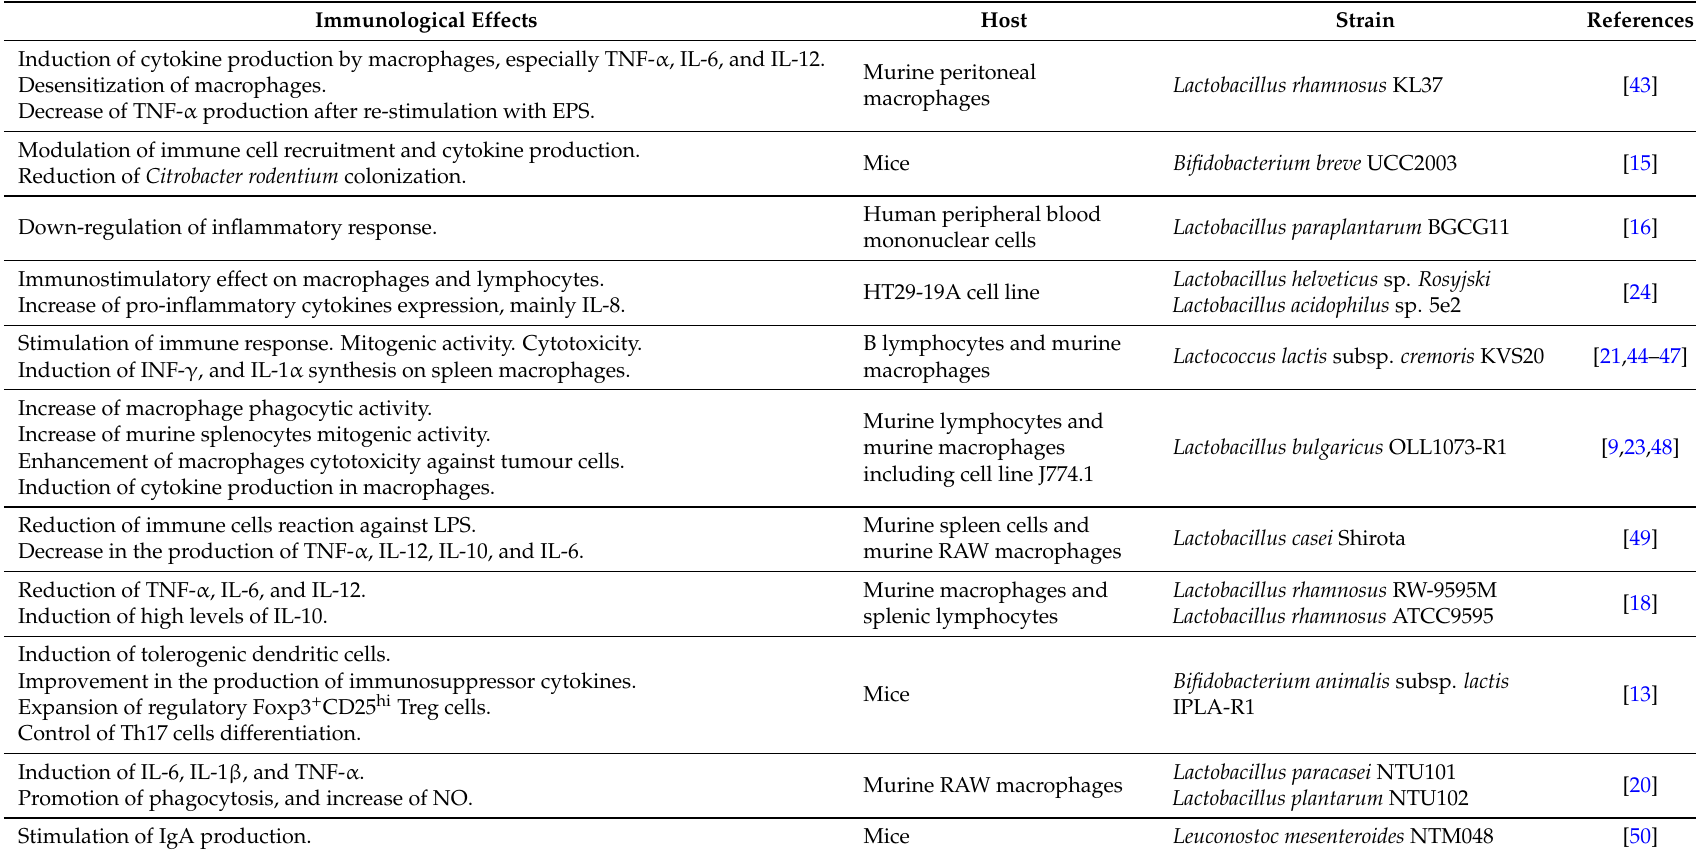
Table 1. Immunomodulatory effects of EPS from lactic acid